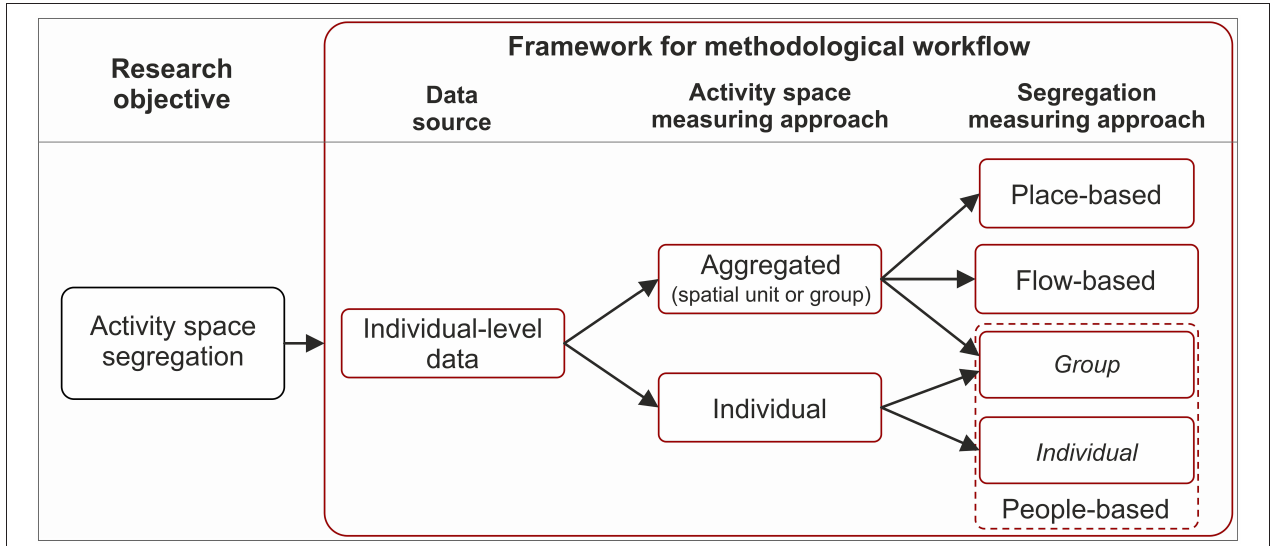
FIGURE 12 | Framework for a three-step methodological workflow for quantitative activity space segregation